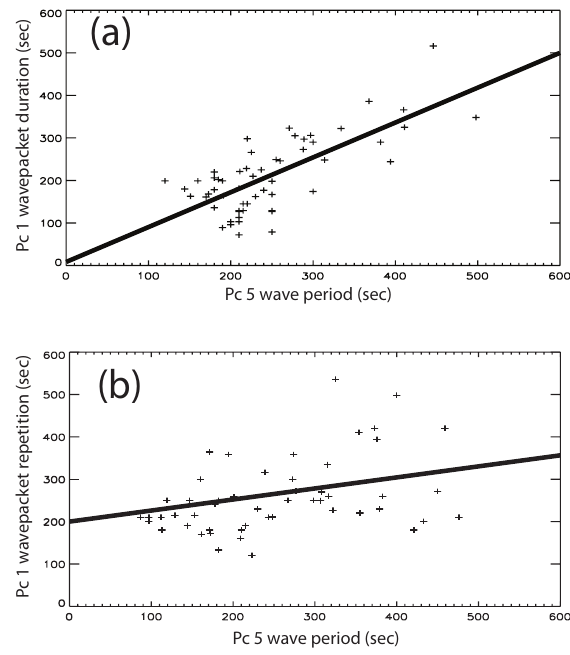
Fig. 6. The Pc 1 wavepacket duration (a) and repetition (b) periods versus Pc 5 wave periods. Note, the 58 wavepacket duration times were taken from 5 pearl events, which corresponds to 53 repetition intervals in (b). Also, since Pc 5 wave periods were measured over both duration and repetition time intervals, the Pc 5 wave period values shown in (a) do not necessarily equal those shown in